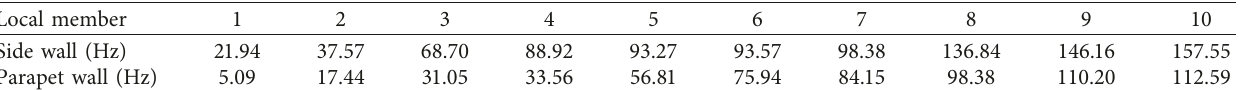
Figure 15: Local modal shapes of the masonry building [13]. (a)Mode 6 ( f Table 6: First through 10th natural frequencies of the building’s side wall and parapet